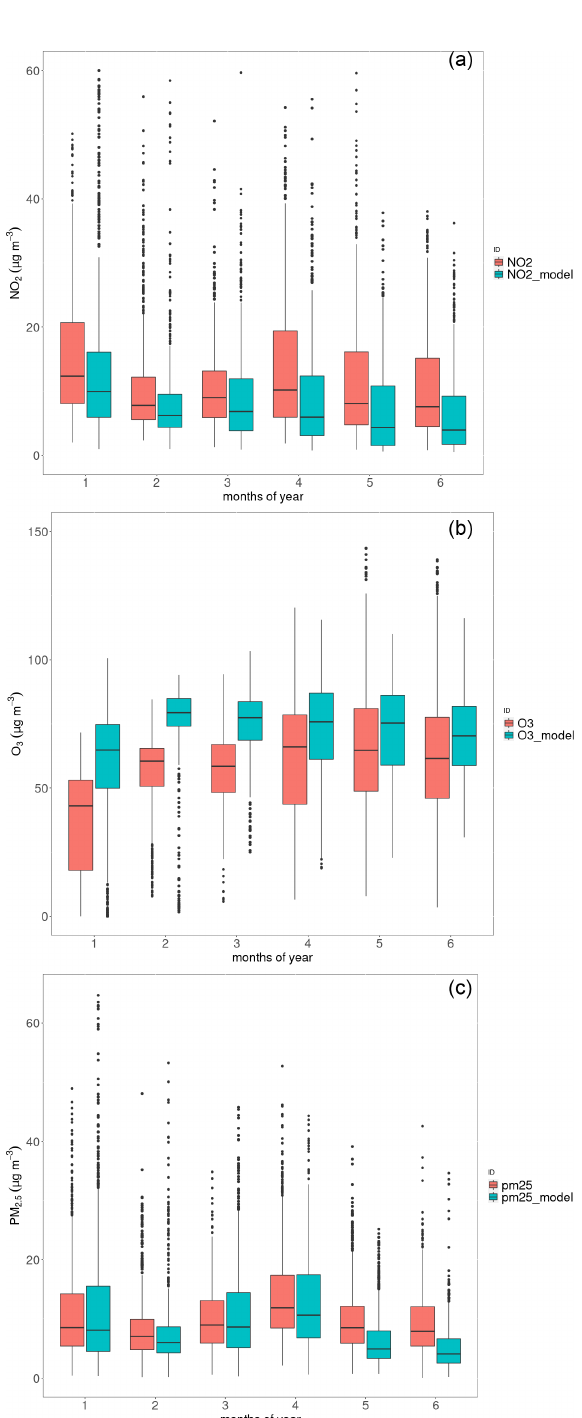
Figure 9. Comparison between model results (green) and observations (red) at Vredepeel, the Netherlands. (a) NO 2 , (b) O 3 and (c) PM 2 . 5 . All concentrations are given in µgm − 3 ; box plots show medians, 25% and 75% quartiles, and whiskers representing 1.5 times the interquar- tile range. Values that fall outside the range of the whiskers are given as